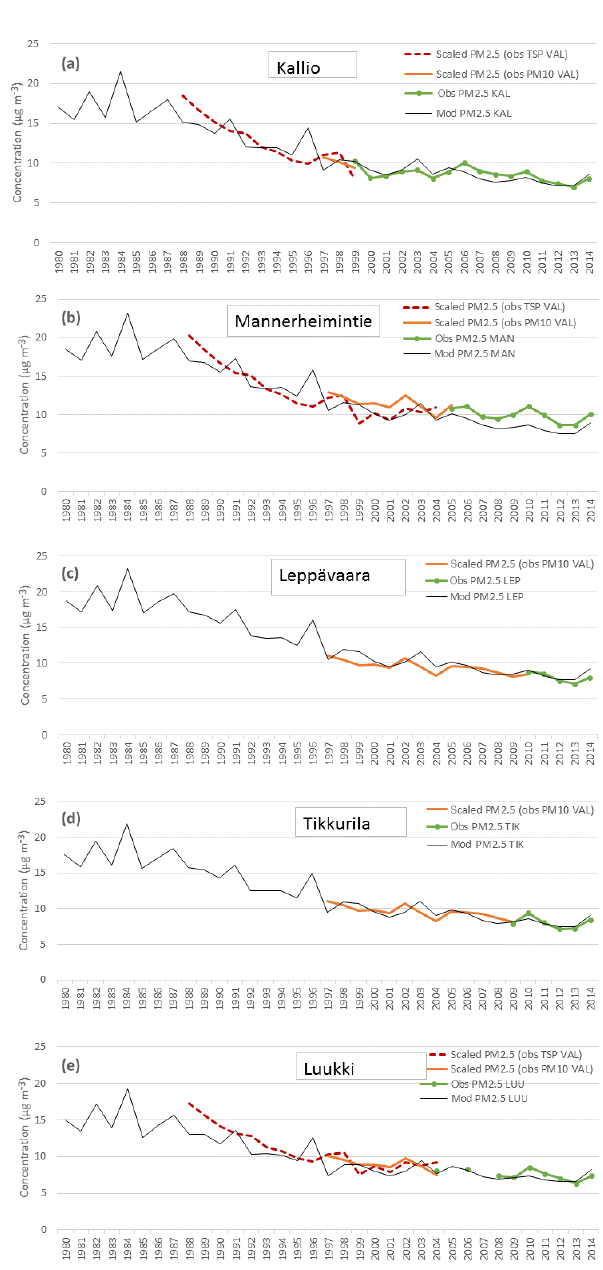
Figure C1. The modelled trends of concentrations of PM 2 . 5 , com- pared with the measured concentrations of PM 2 . 5 , and with the scaled concentrations, which were based on the measurements of the proxy variables PM 10 and TSP. The modelled PM 2 . 5 values have been presented by the black lines, the observed values of PM 2 . 5 with the green lines, and the scaled concentrations with the orange (based on PM 10 ) and dashed dark red (based on TSP)